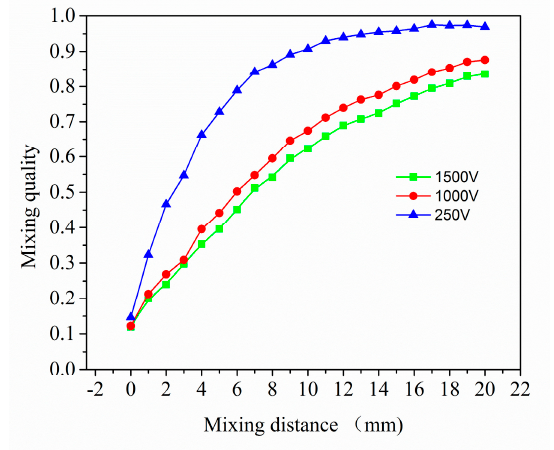
Figure 7. Comparison of mixing quality in Electro-osmotic flow (EOF) along the main channel with three electric potential: 250 V, 1000 V, 1500 V.